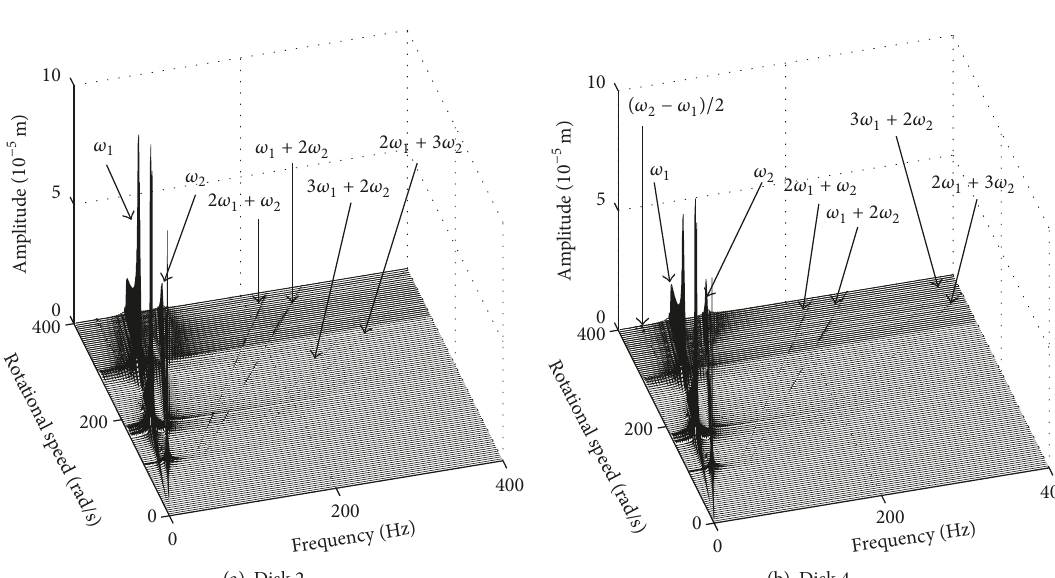
Figure 4: Spectrum cascade of the horizontal response of disks 2 and 4, numerical simulation. 𝜆 = −1.65